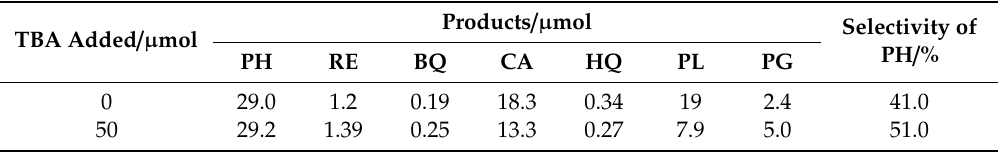
Table 3. E ff ects of tertiary butyl alcohol (TBA) added on the photocatalytic hydroxylation of benzene on the Pt(0.2)-WO 3 photocatalyst under visible light irradiation for 20 h under air. TBA Added / µ